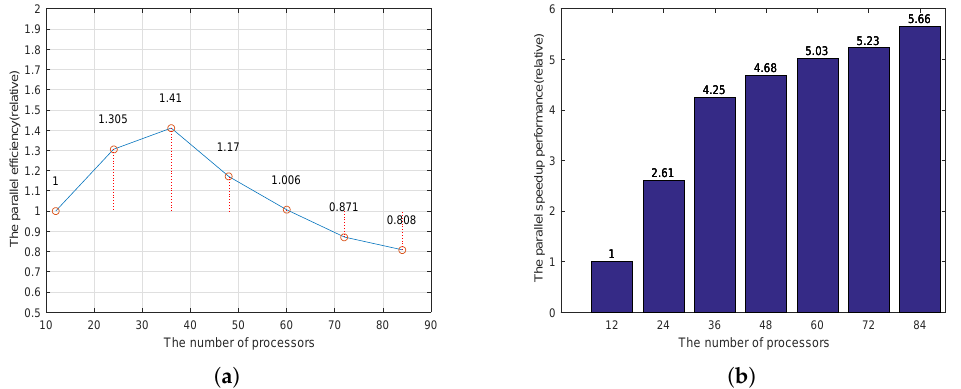
Figure 13. ( a ) the parallel efficiency of the numerical solver based on OpenFOAM; ( b ) the parallel speedup of the numerical solver based on